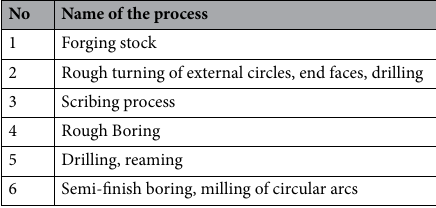
Table 1. Some key machining processes of piston skirt.